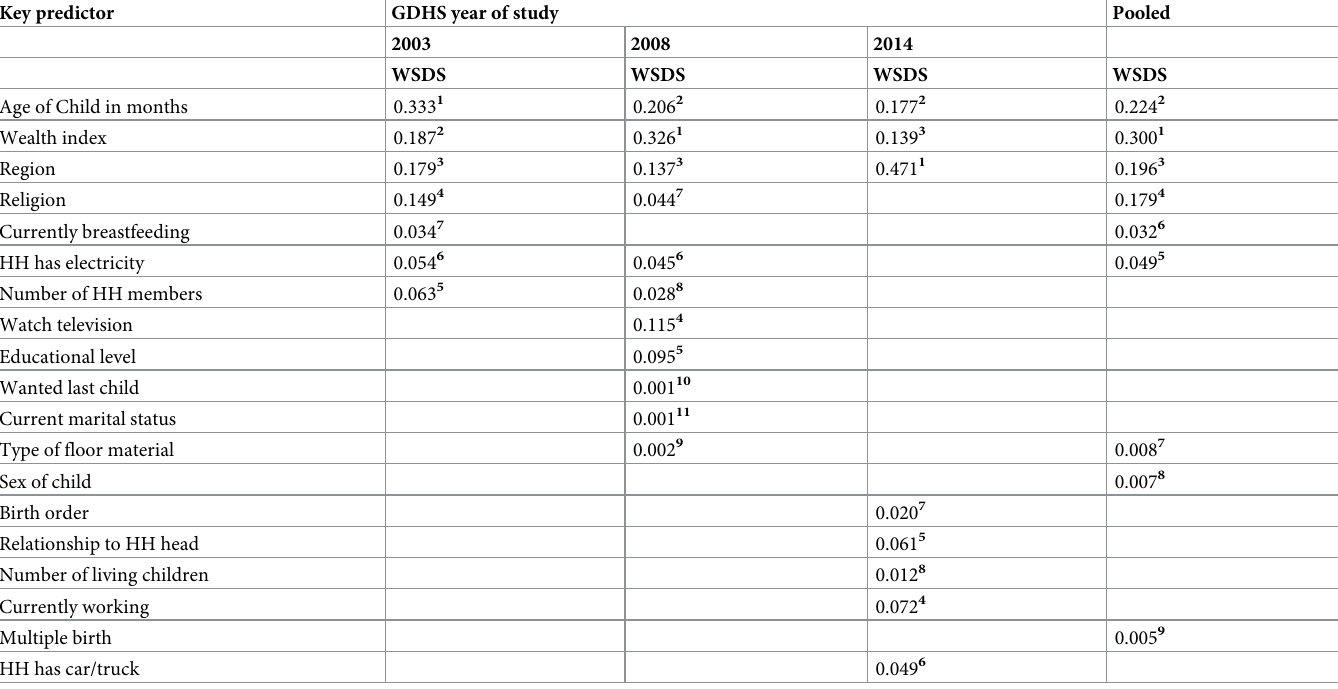
Table 3. Relative importance of factors significantly associated with hygienic disposal of stools among women with children under two years in Ghana, GDHS